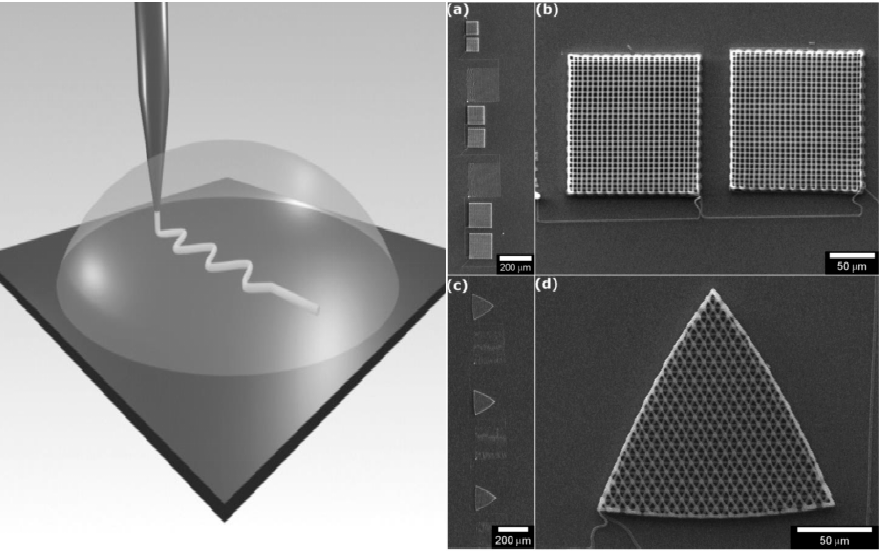
Figure 2. Direct ink writing of three-dimensional microperiodic structure Reprinted with permission [22]. Copyright (2007) American Chemical Society. sion [22]. Copyright (2007) American Chemical